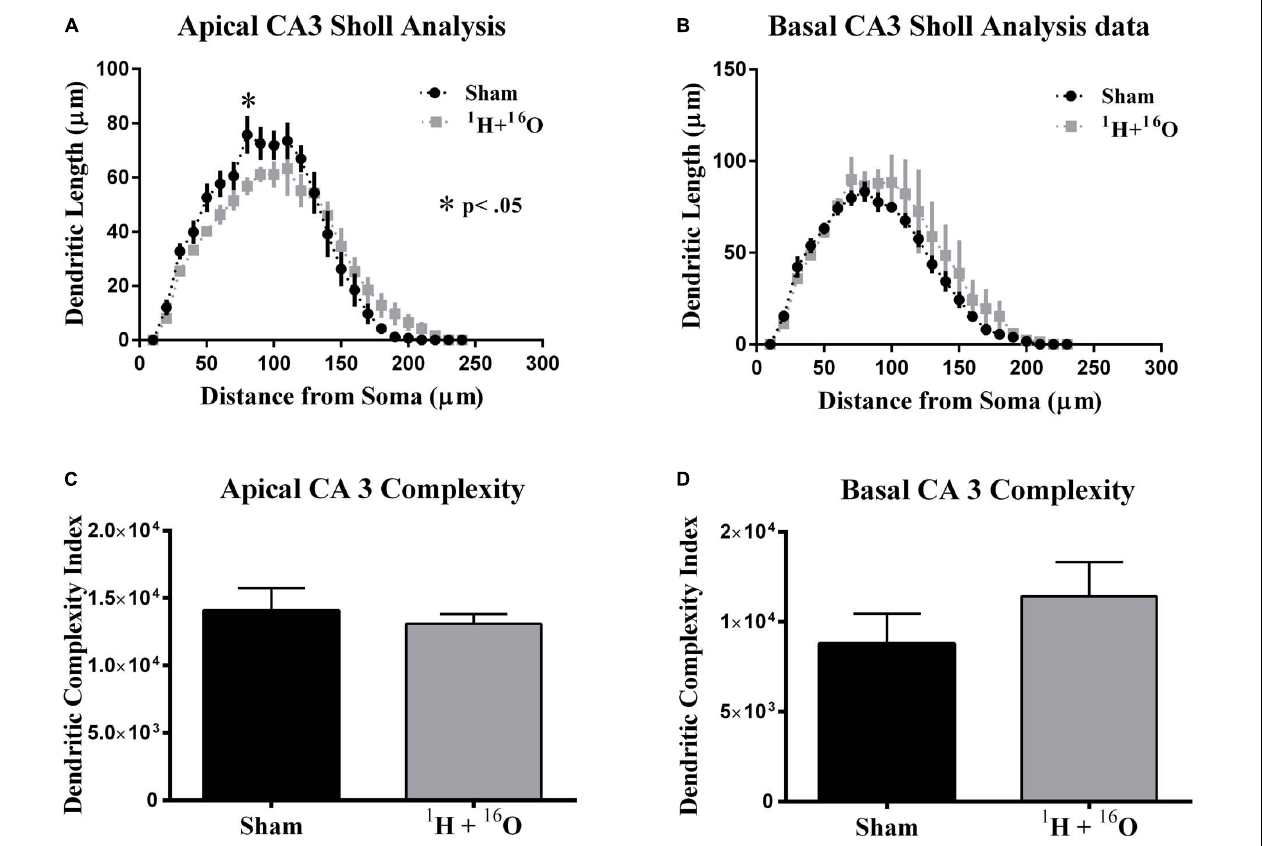
FIGURE 5 | Ventral CA3 dendritic morphology. (A) Apical CA3 Sholl analysis reveals very minor changes to the dendritic arbor. (B) No significant changes in dendritic length were observed in basal CA3 pyramidal dendrites. (C,D) Dendritic complexity was similar in both the apical and basal subdivisions of the CA3 between cohorts. Average ± SEM ( n = 5); * P < 0.05, **** P <